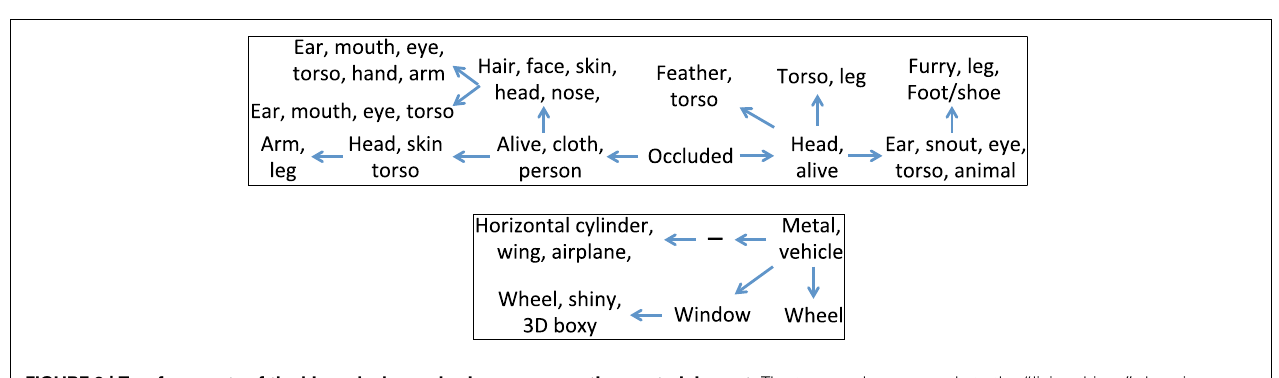
training set. The top panel corresponds to the “living things” domain, whereas the bottom panel corresponds to the “transportation” domain. The sign ( − ) denotes an internal